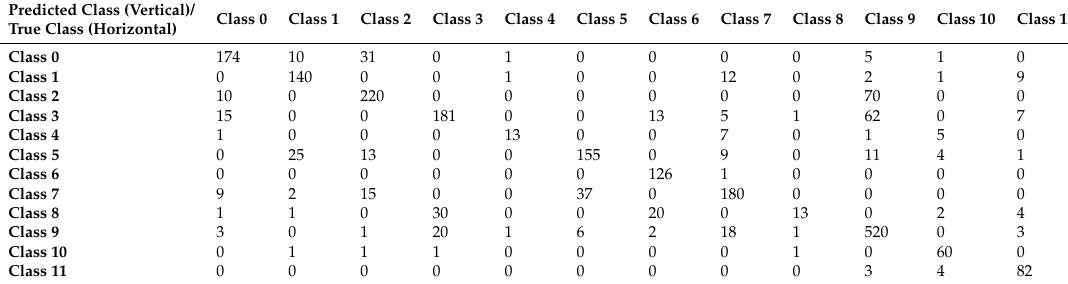
Table 9. Confusion matrix